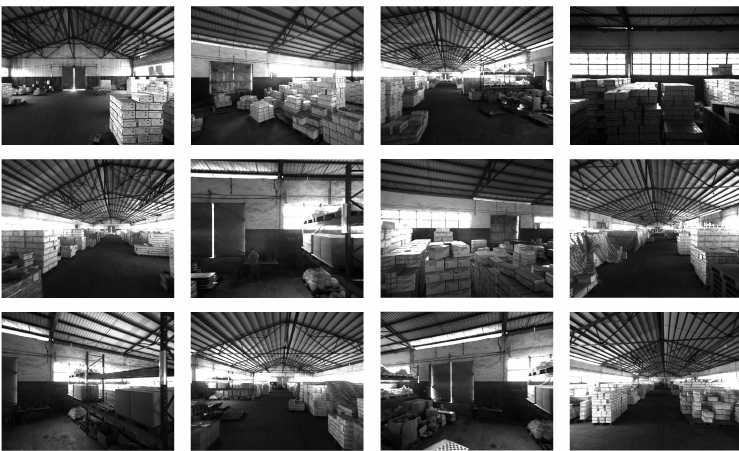
Figure 5. Sample images from the warehouse dataset, which contains the typical scene in the warehouse and these images from the left